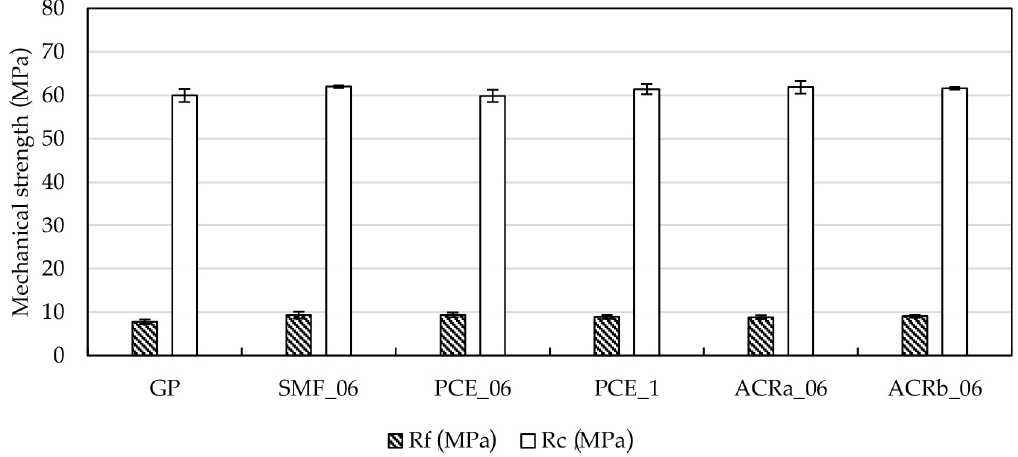
Figure 4. Mechanical properties of hardened geopolymer mortars after 28 days of curing at room temperature (values are reported as average of three measurements).